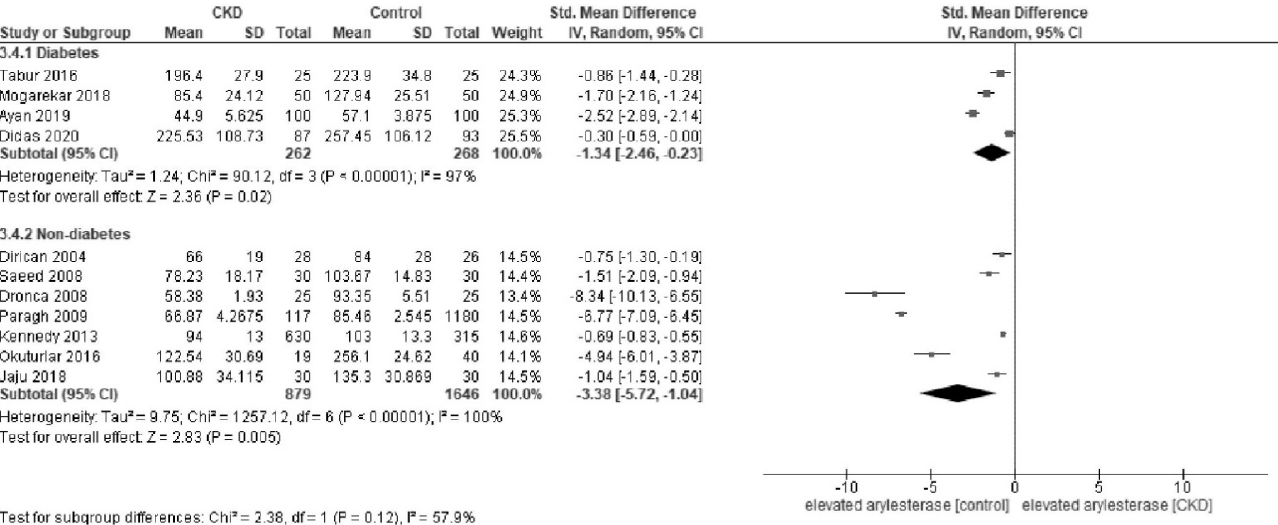
Figure A3. Forest plot of arylesterase activity stratified by diabetes status